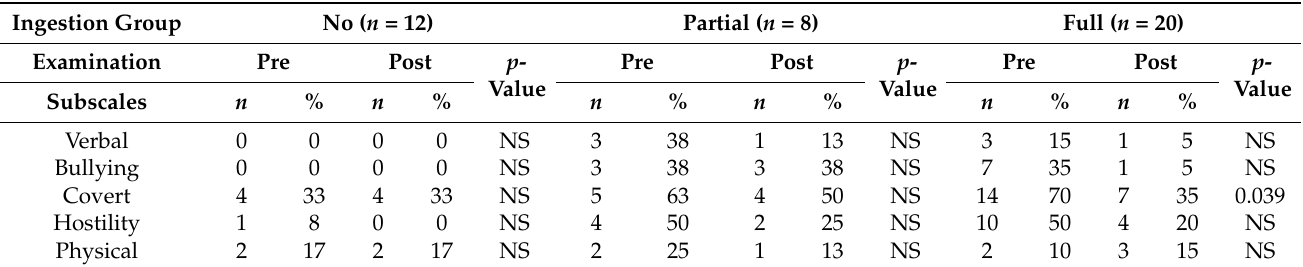
Table 4. Comparisons of the prevalence of children with high C-SARP aggression subscale scores between the pre- and post-intervention examinations in the DBB-intervention group in Thanh Khe.